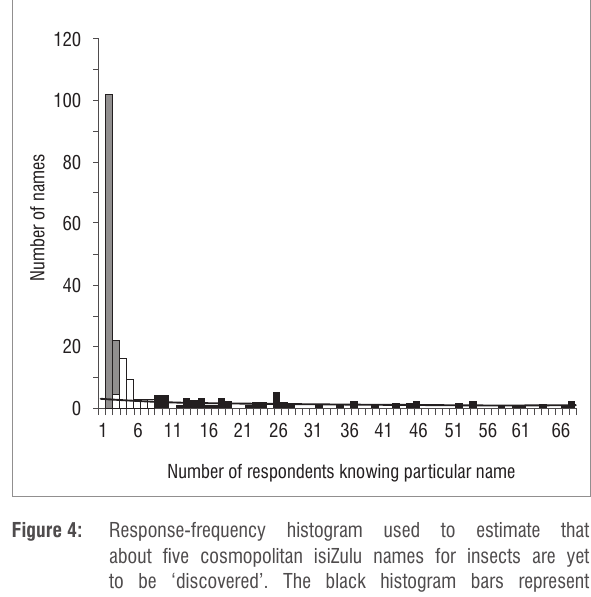
Figure 4: Response-frequency histogram used to estimate that about five cosmopolitan isiZulu names for insects are yet to be ‘discovered’. The black histogram bars represent cosmopolitan names, and the point at which the black line fitted to them intersects with the y -axis provides an estimate of how many names are known by 0 people in the sample, i.e. await